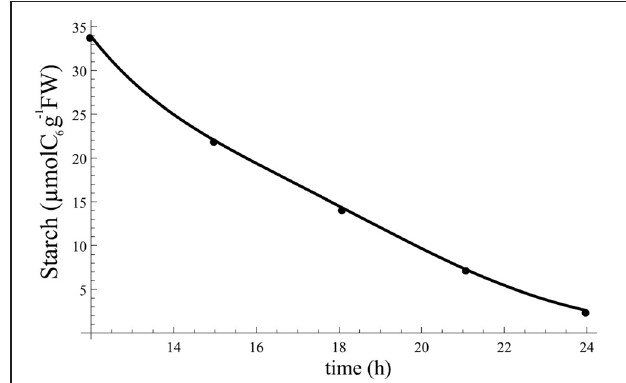
FIGURE A1 | Starch profile at night resulting from fitting Equation (A1) to data and using β ( t ) . Points indicate the data to which Equation (A1) was fitted.